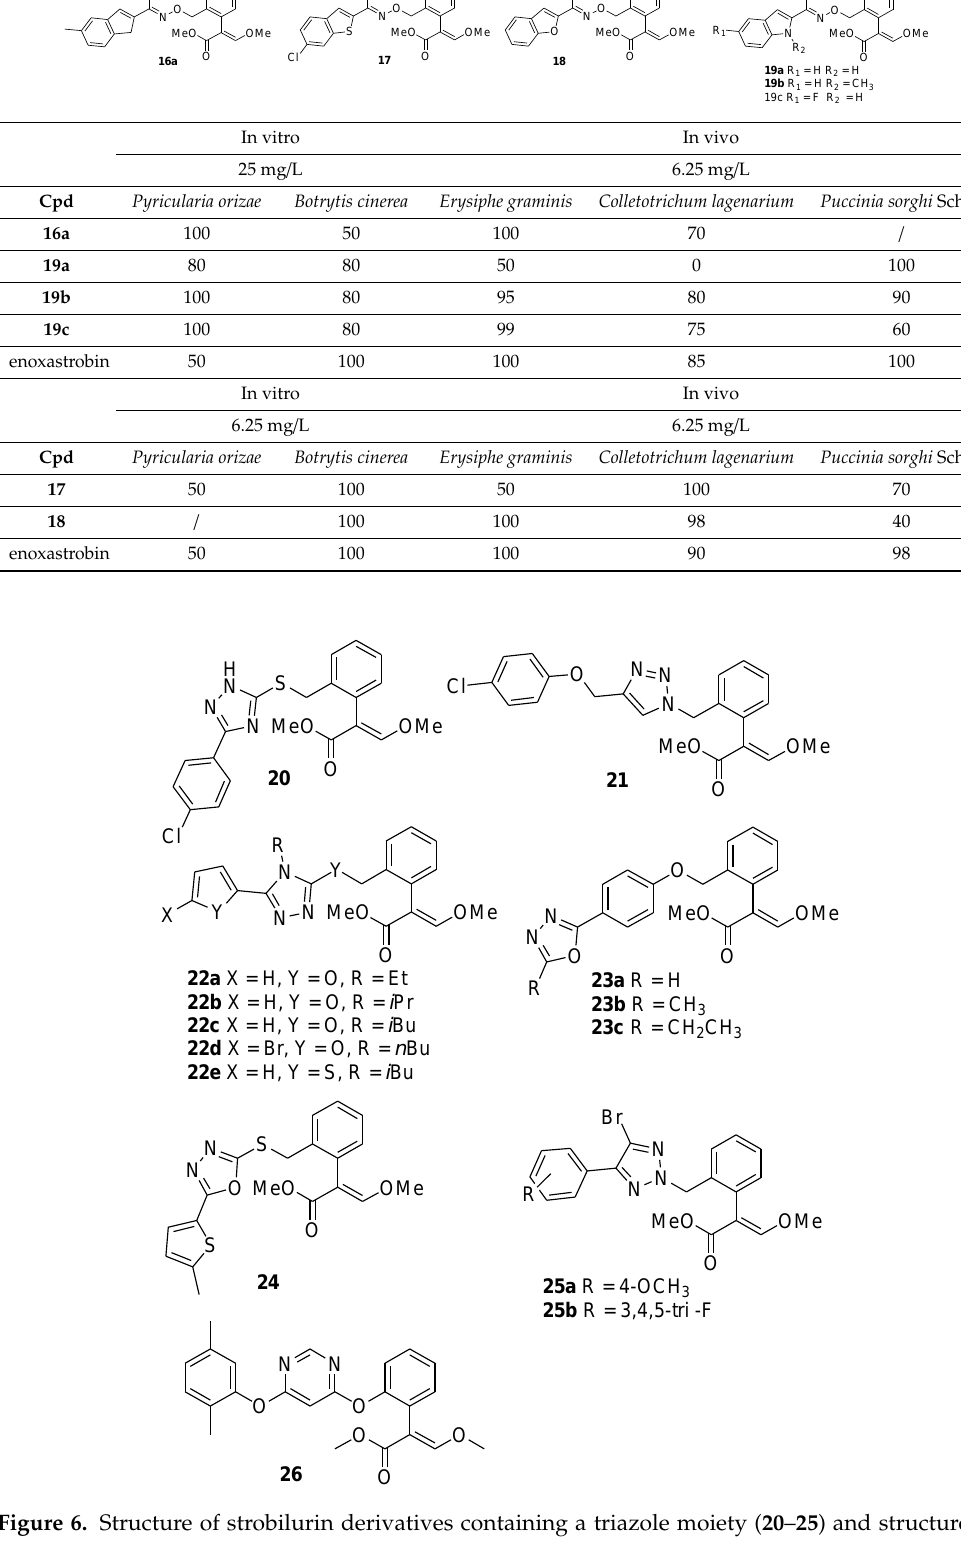
Figure 5. Enoxastrobin-inspired analogs.